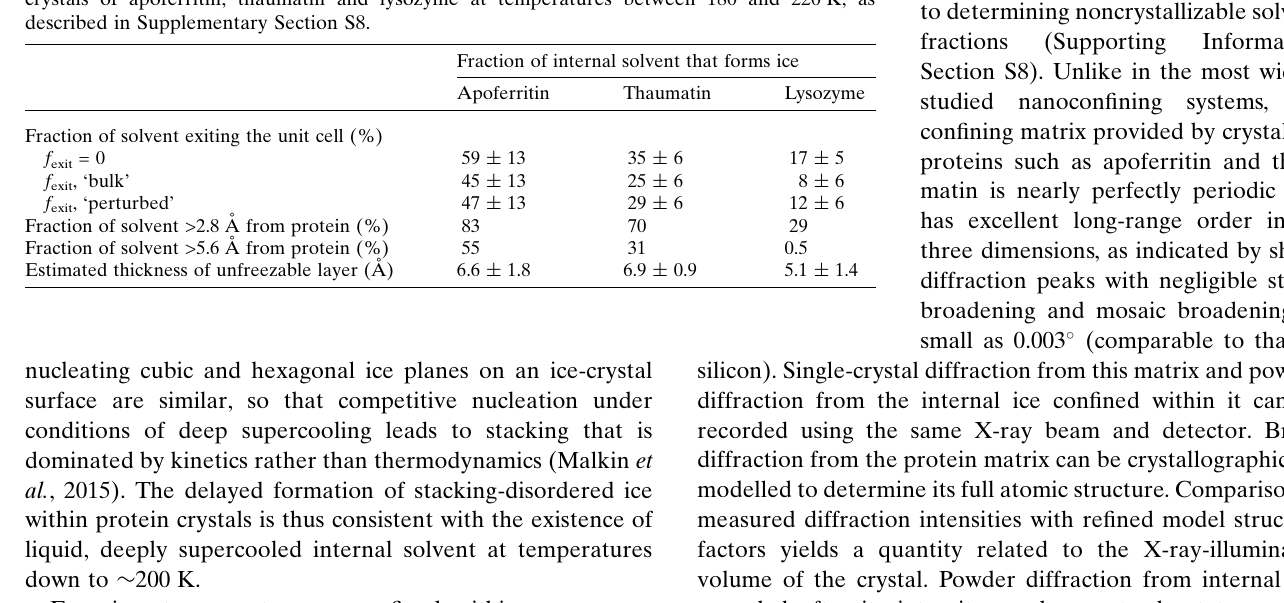
Table 2 Estimates of the maximum fraction of the solvent-cavity space occupied by ice in glycerol-free crystals of apoferritin, thaumatin and lysozyme at temperatures between 180 and 220 K, as described in Supplementary Section S8. Fraction of solvent exiting the unit cell (%)